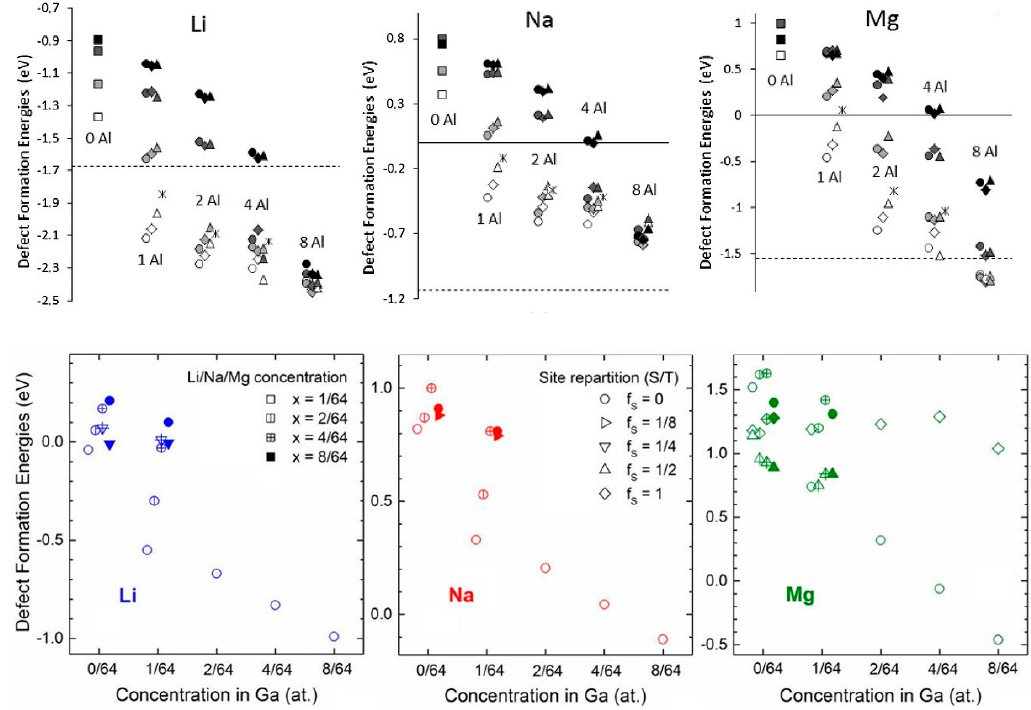
Figure 8. ( Top ): Defect formation energies versus the vacuum reference state (in eV) for Li, Na and Mg insertion, respectively, in pure and Al-doped Si, with different numbers of Al atoms in a 64-atom simulation cell. Shades of grey from white to black are for different numbers of inserted Li, Na, or Mg. Different shapes of the symbols correspond to different proximity of Li, Na, or Mg to Al atoms. The dashed lines indicate the cohesive energy of Li/Na/Mg (threshold below/above which the insertion of Li/Na/Mg is favored/unfavored versus bulk Li/Na/Mg metal), and the solid lines (for Na and Mg) indicate the zero value for the defect formation energies (threshold below/above which the insertion of Li/Na/Mg is favored/unfavored versus Li/Na/Mg in vacuum). ( Bottom ): Defect formation energies (in eV and vs. bulk Li, Na, or Mg, respectively) associated with Li/Na/Mg insertion in pure and Ga-doped Ge. Different concentrations of Ga are considered (on the x axis) as well as different concentrations of Li/Na/Mg ( x = 1/64—empty circles, 2/64—circles with one vertical bar, 4/64—circles with two perpendicular bars, 8/64—full circles). The configurations include different repartitions of tetrahedral and substitutional sites. The symbols indicate the fraction of substitutional sites f s ( f s = 0—circles, f s = 1/8—triangles rotated by 90°, f s = 1/4—triangles rotated by 180°, f s = 1/2—triangles, f s = 1—rhombuses). Reprinted with permission from [24], © (2015) Elsevier (top panels) and from [37], © (2017) Elsevier (bottom panels).